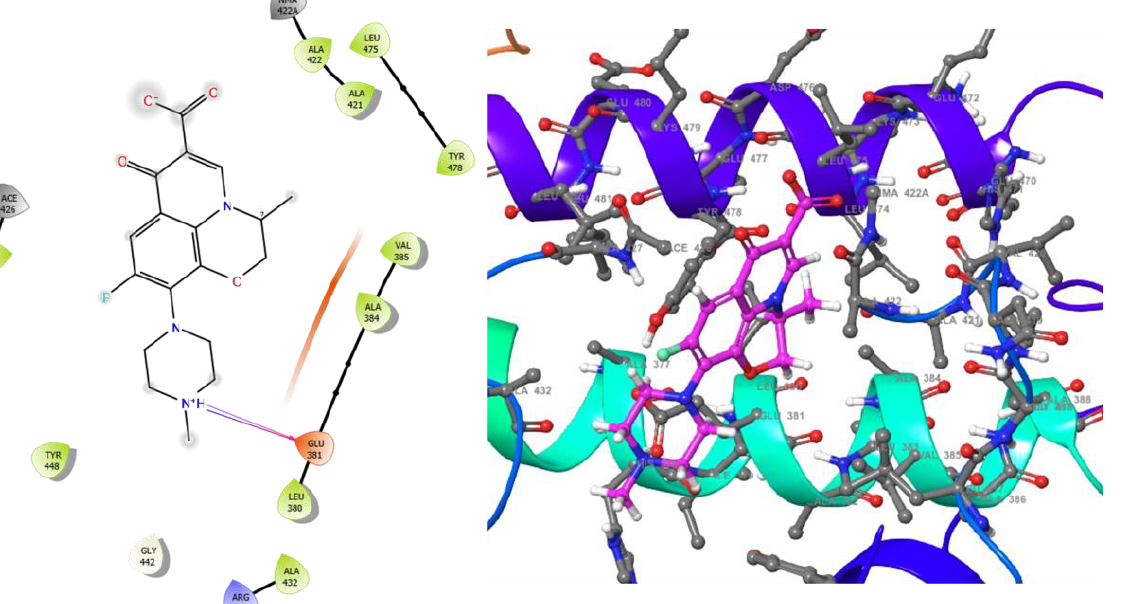
Figure 6. 2D ( left ) and 3D ( right ) views of the molecular interactions at the surface of the active site of E. coli DNA gyrase–DNA binding and cleavage domain in State 1 binding with levofloxacin (the green stick model). The negative, positive, and neutral charges of the binding site residues are represented with red, blue, and white colors, respectively.